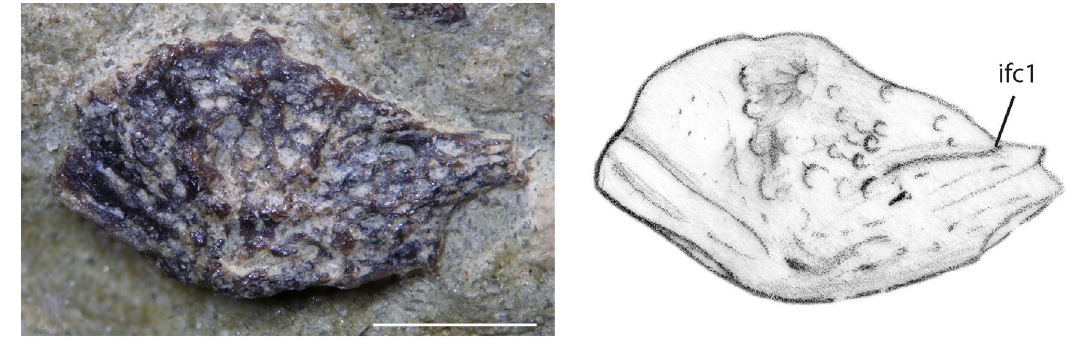
Fig. 4. Microbrachius kedoae from the Gavrilchitsy 45 borehole. GIT 767-7, a right paranuchal plate in dorsal view. Scale bar = 1 mm. Abbreviation: ifc1, principle section of infraorbital sensory line.